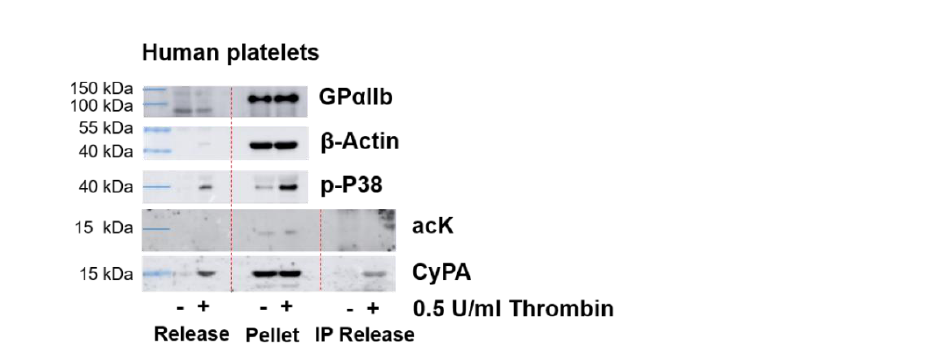
demonstrating CyPA secretion only in activated platelets. No lysine acetylation (acK) of CyPA was